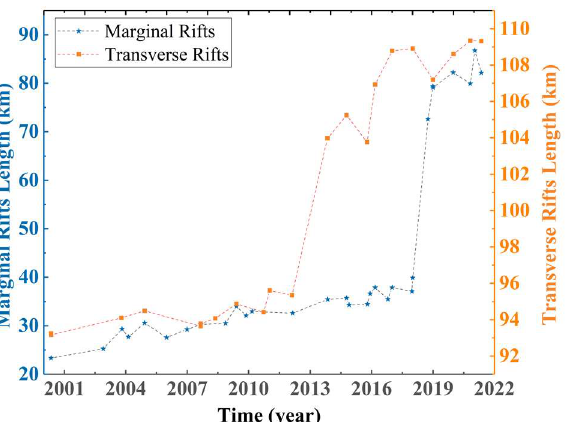
Figure 6. The length of rifts has changed over time, from 2000 to 2022. The left axis represents changes in the development of marginal rifts (blue), while the right axis represents changes in the development of transverse rifts